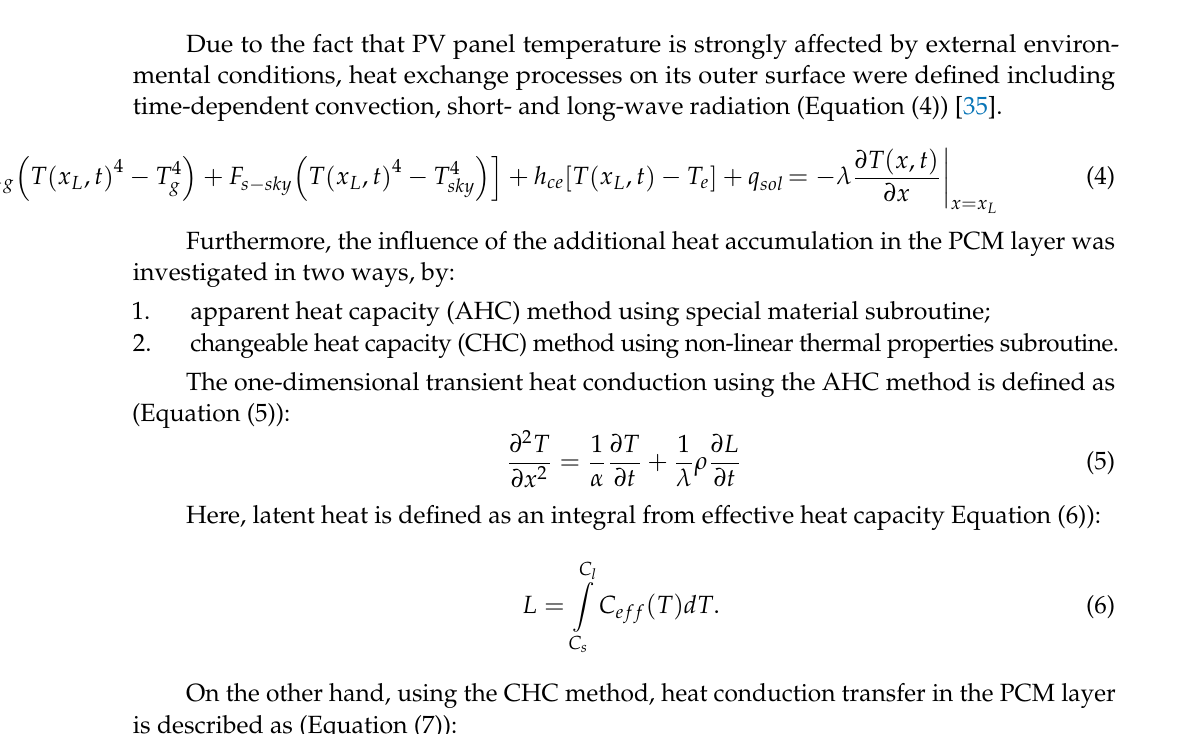
Table 2. Thermal characteristics of the PV panel. Parameter Unit Value Temperature coefficient Voc [%/ ◦ C] − 0.3 Temperature coefficient Isc [%/ ◦ C] 0.01 Temperature coefficient Pmpp [%/ ◦ C] −